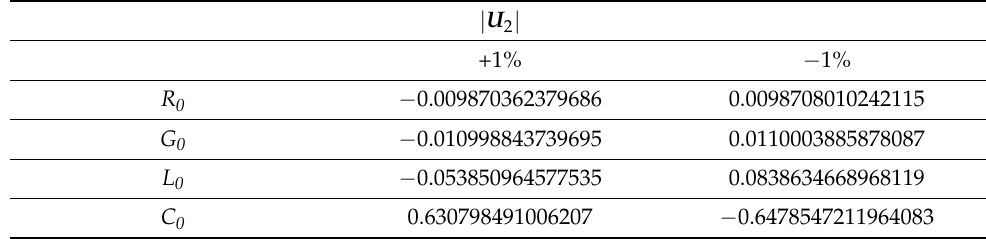
Table 8. Changes to the U 2 voltage modulus.